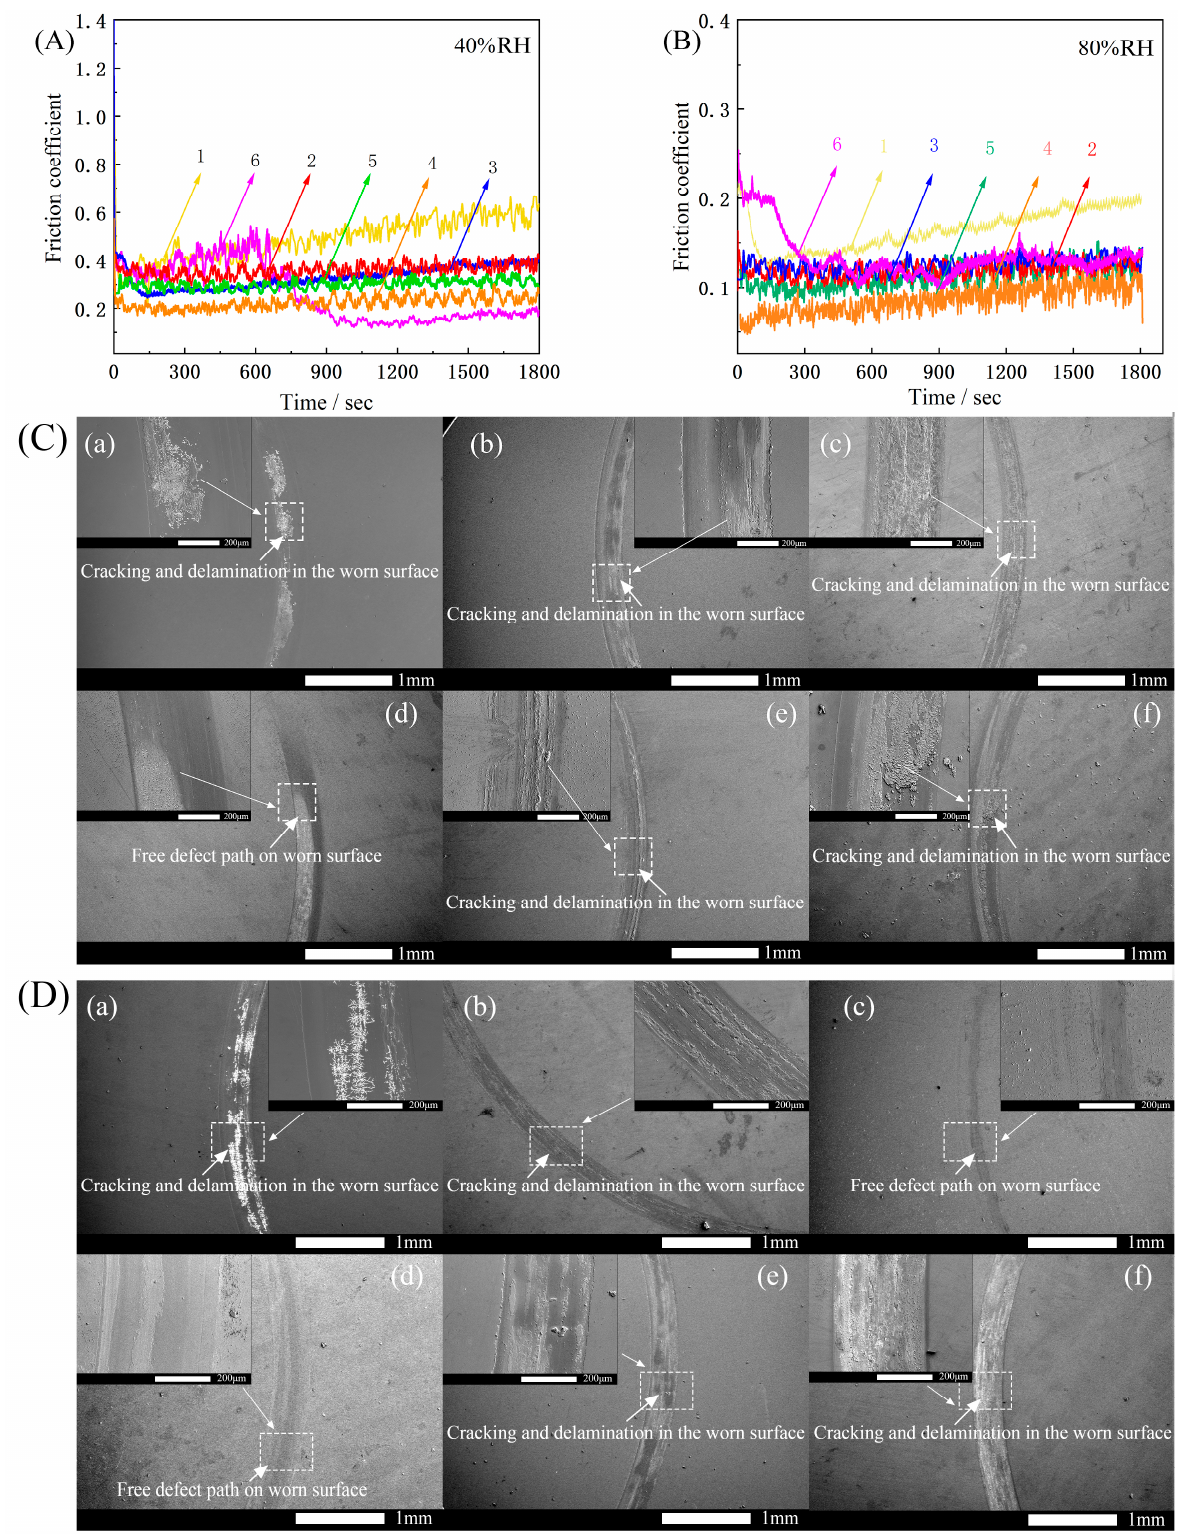
Figure 8. ( A ) Friction coefficient curves of Si-B-C-N/DLC gradient films at 40% RH. ( B ) Friction coefficient curves of Si-B-C-N/DLC gradient films at 80% RH. ( C ) Surface morphology of Si-B-C-N/DLC gradient film after wear at 40% RH. ( D ) Surface morphology of Si-B-C-N/DLC gradient film after wear at 80% RH.